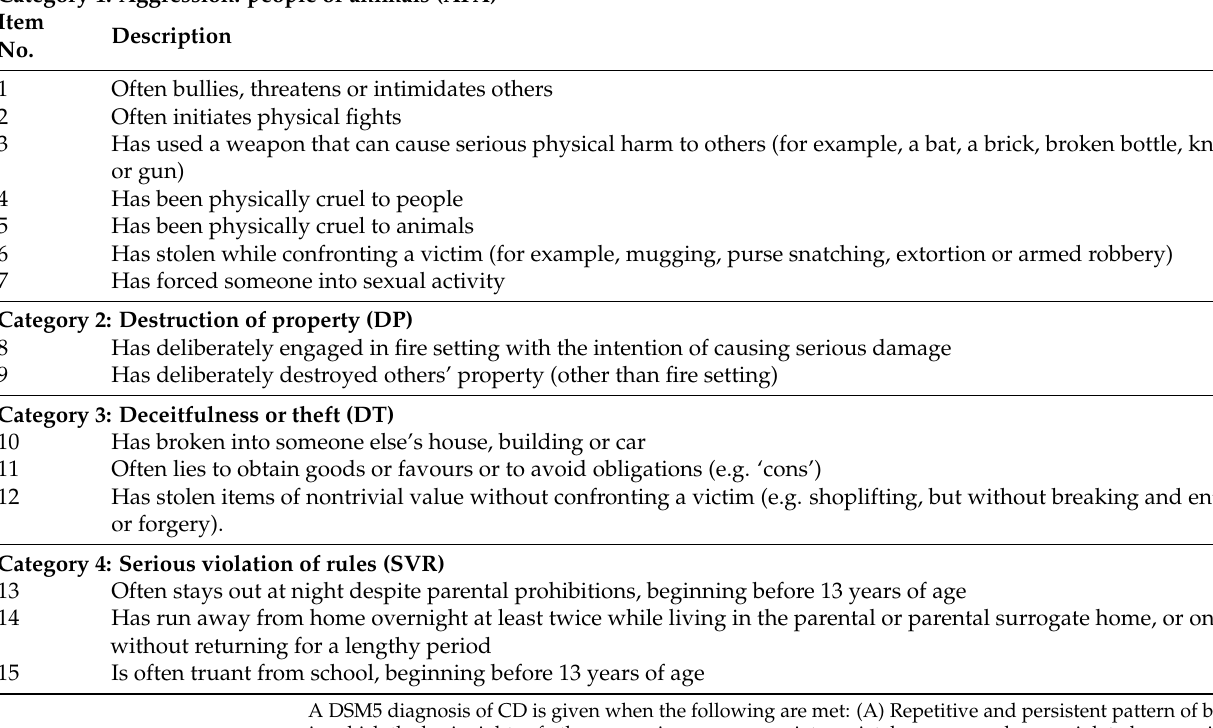
Table 1. Diagnostic and Statistical Manual Version 5 (DSM-5) 15 Criteria for Conduct Disorder (CD) and the